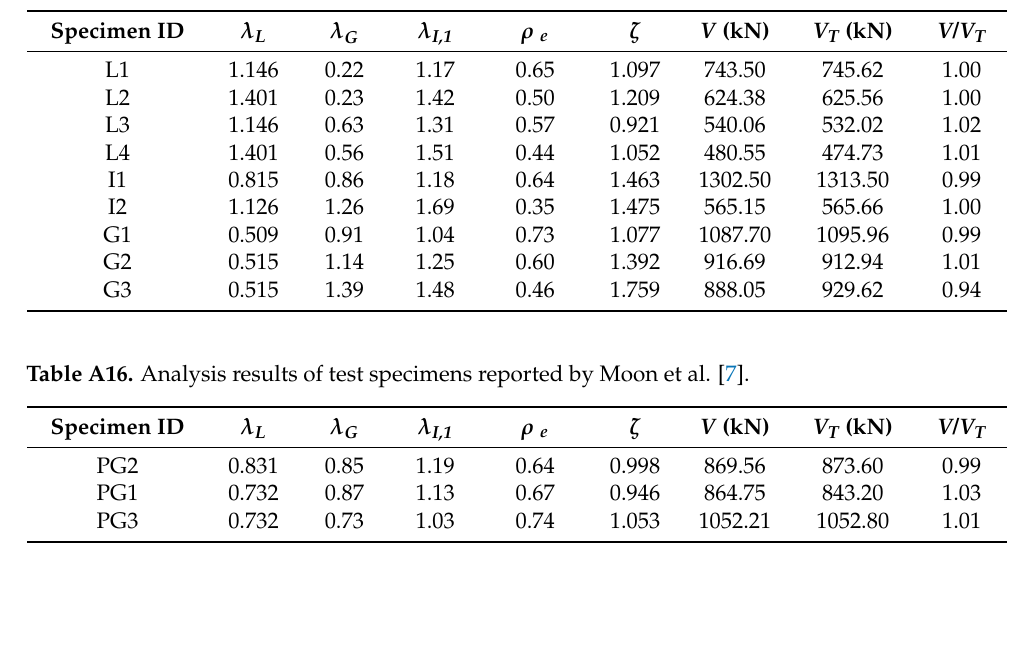
Table A15. Analysis results of test specimens reported by Lee et al. [28].